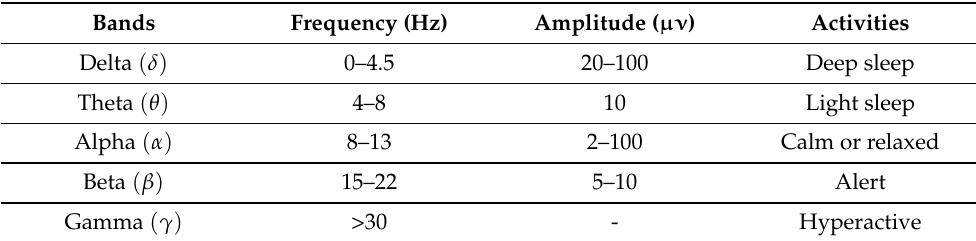
Table 3. EEG waveform frequency